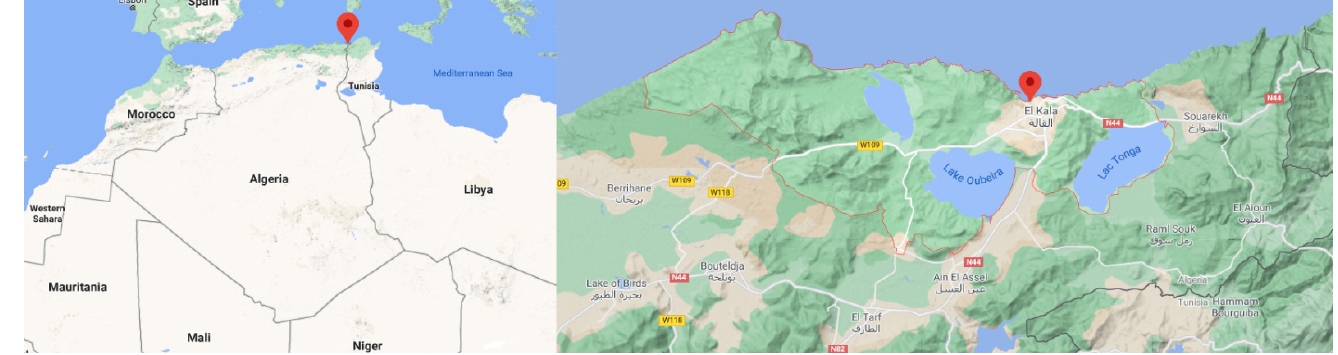
Figure 7. The topography of Algeria, indicating El Kala region boundaries (36°49 ′ 09 ″ N; 08°31 ′ 33 ″ ).